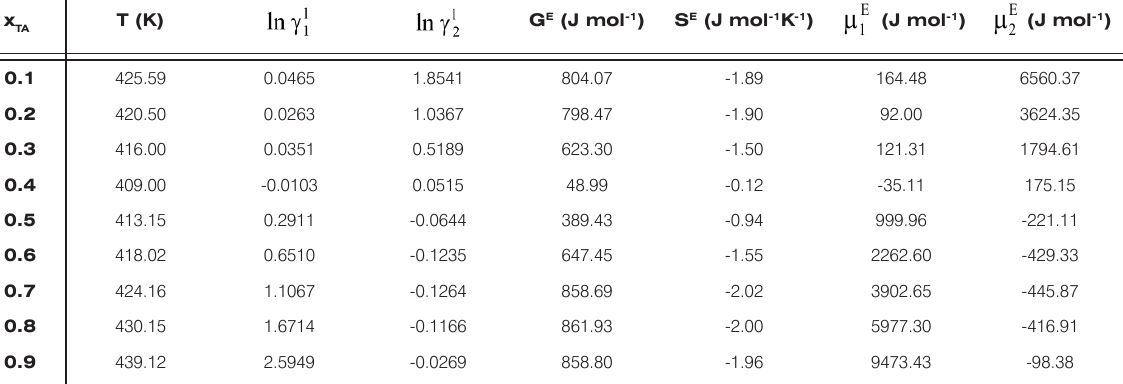
Table 3. Activity coefficients and excess thermodynamic function data for binary mixture. x T TA